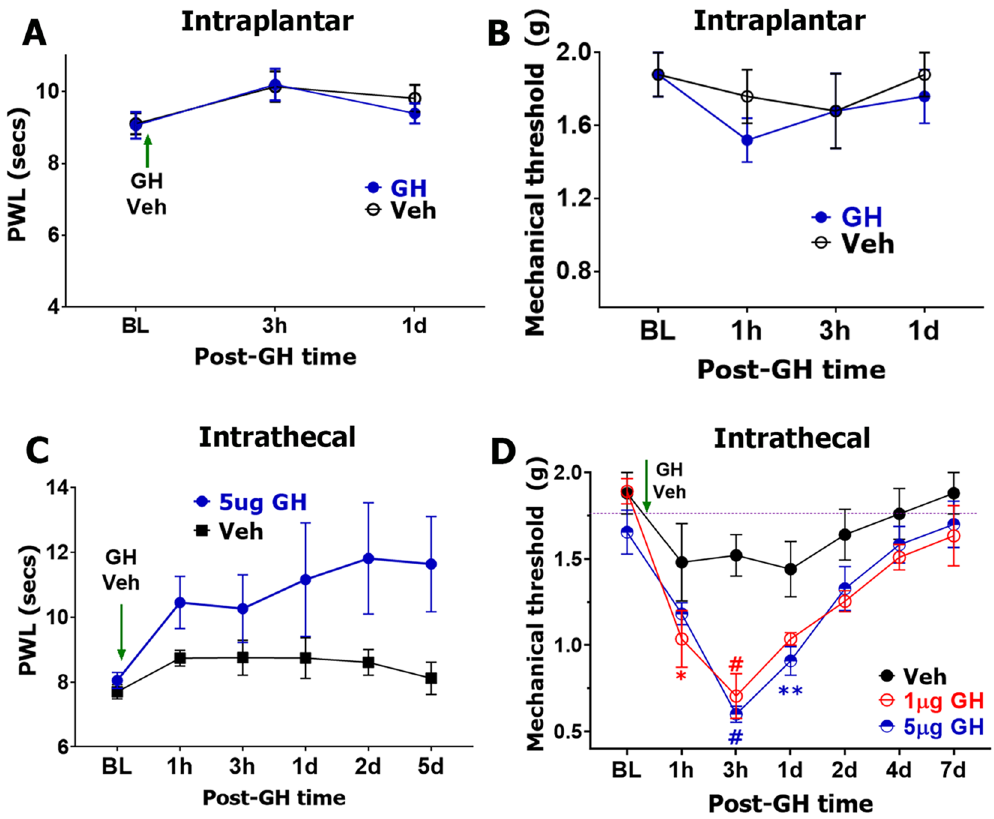
Figure 7. GH-induced acute hypersensitivity in the spinal system. ( A ) Measurement of heat thresholds of hindpaws (as paw withdrawal latency (PWL)) after intraplantar (i.pl.) injection of GH (5 μg) or vehicle (PBS). N = 6. ( B ) Mechanical thresholds of hindpaws after intraplantar (i.pl.) injection of GH (5 μg) or vehicle. N = 5 ( C ) Measurement of heat thresholds of hindpaws (as PWL) after intrathecal (i.t.) injection of GH (5 μg) or vehicle (PBS). N = 5–6. ( D ) Mechanical thresholds of hindpaws after intrathecal (i.t.) injection of indicated dosages of GH or vehicle. N = 6–11. Statistic is 2-way ANOVA, Sidak’s post hoc test (NS—non-significant; ** p < 0.01; ** p < 0.01; # p < 0.0001). Dosages of GH are specified on some panels. Vehicle or GH single administration time point is indicated on every panel with the green vertical arrow. GH delivery route is indicated above each